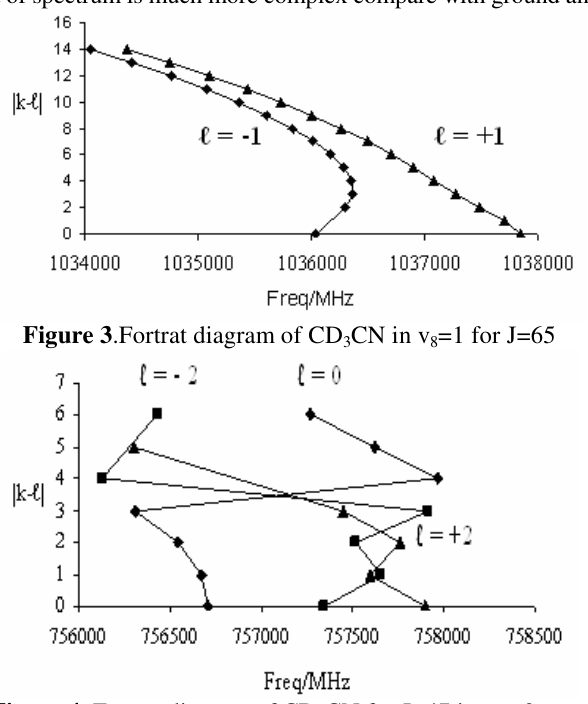
CN for J=47 in v 3